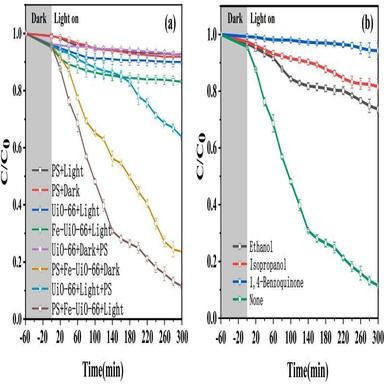
(a) Photocatalytic degradation of sulfameter under various conditions and (b) photocatalytic degradation efficiency of sulfameter by Fe-UiO-66 with different quenchers.